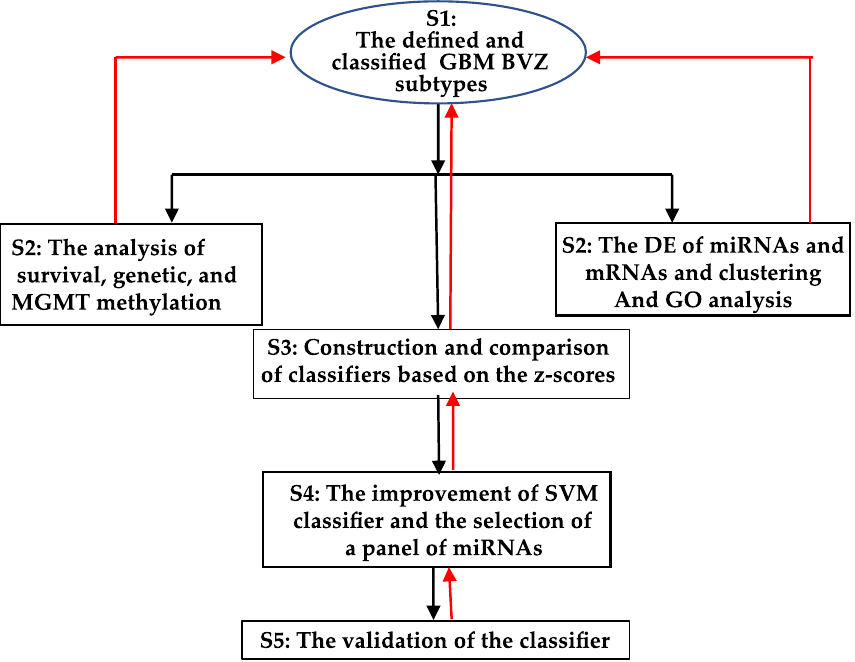
Figure 1. The experimental procedures. ( A ) The defined and classified BVZ subtypes of GBM. ( B ) This step includes several parts of the analyses. ( C ) The construction and comparison of classifiers based on the miRNA expression z-scores and clinical datasets. ( D ) The optimization of a panel of miRNAs, including miR-21, miR- 10b, and miR-197, and the modification and cross-validation of the SVM classifier based on clinical datasets. ( E ) The validation of the classifier using other datasets. In this figure, black lines and arrows indicate the workflow, and red lines and arrows indicate that the results obtained call back and support the previous work or